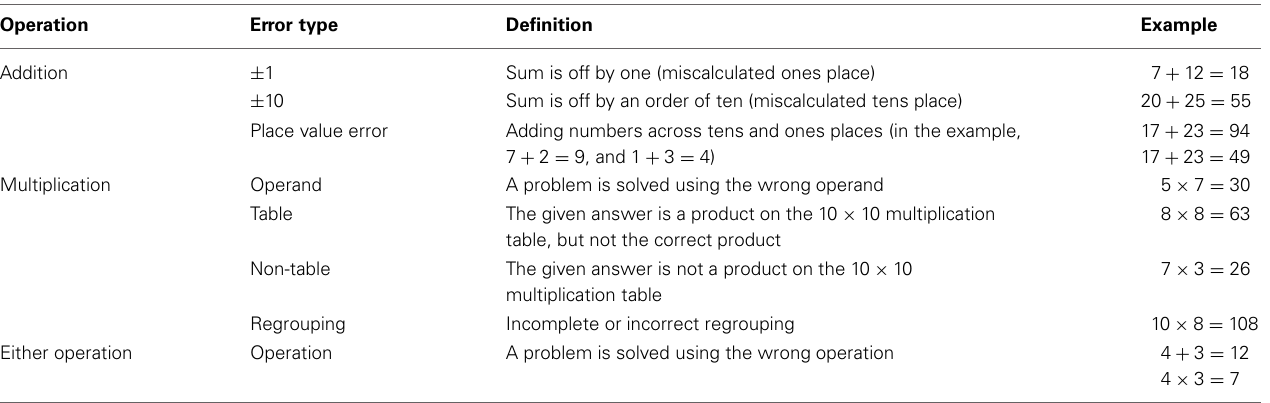
Table 3 | Types of errors coded on the Fast Math Test